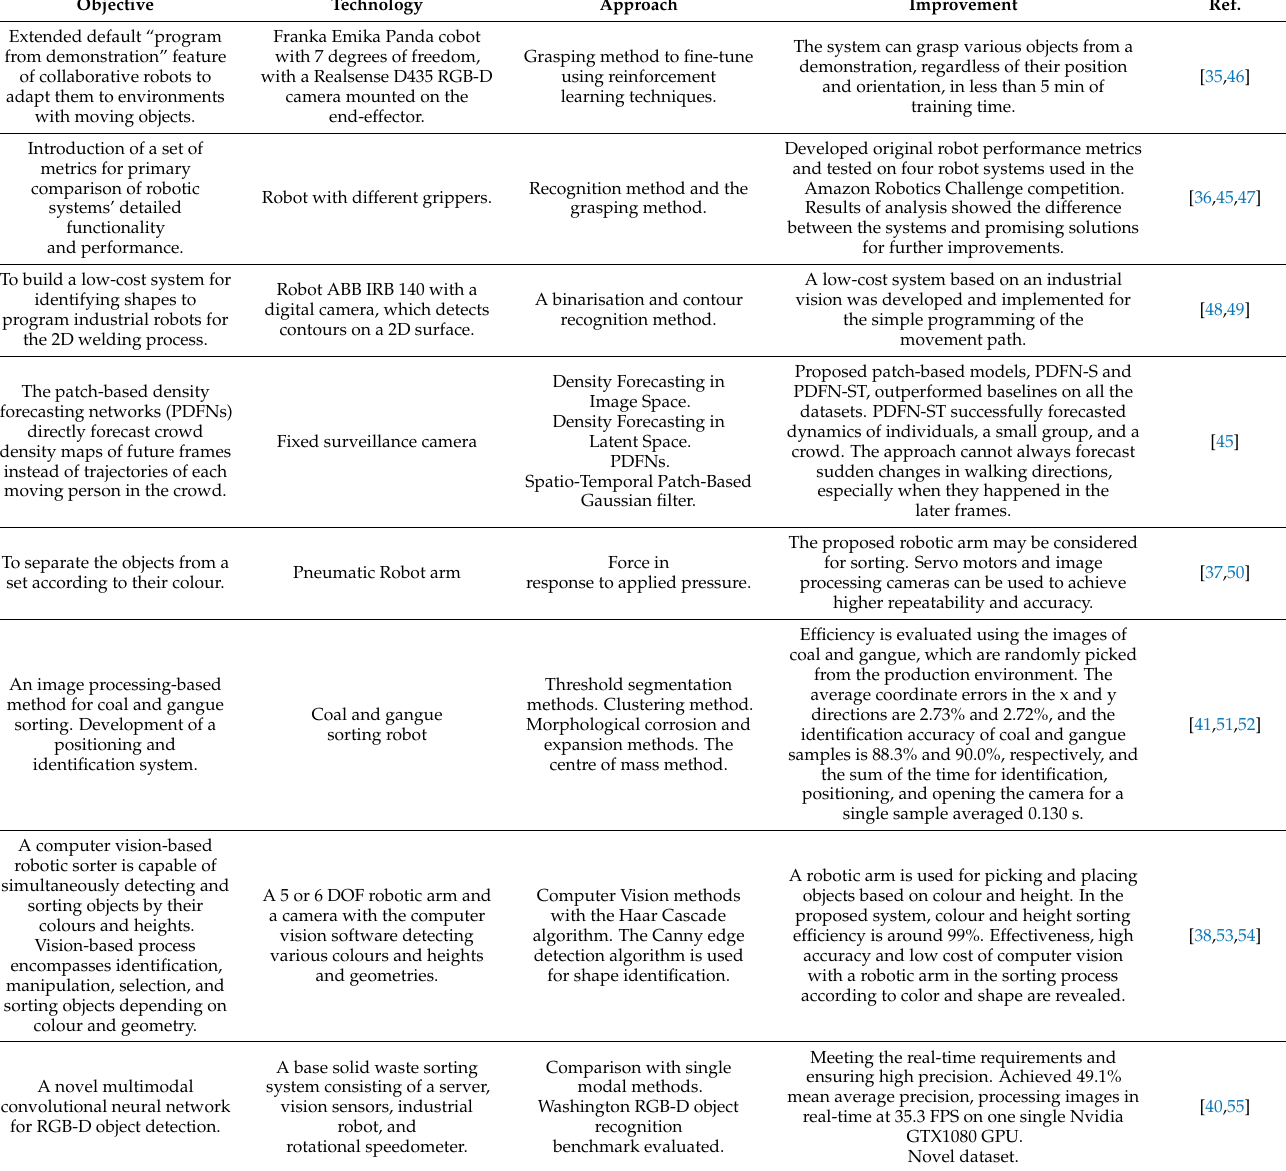
Table 3. Research focused on object recognition in